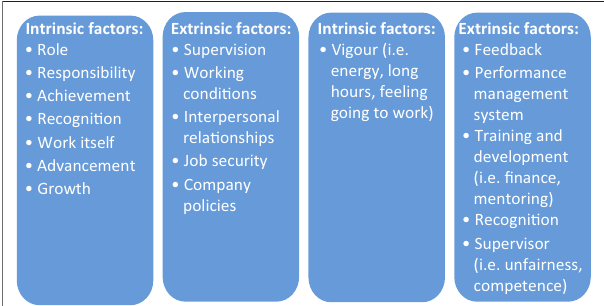
FIGURE 4: Intrinsic and extrinsic